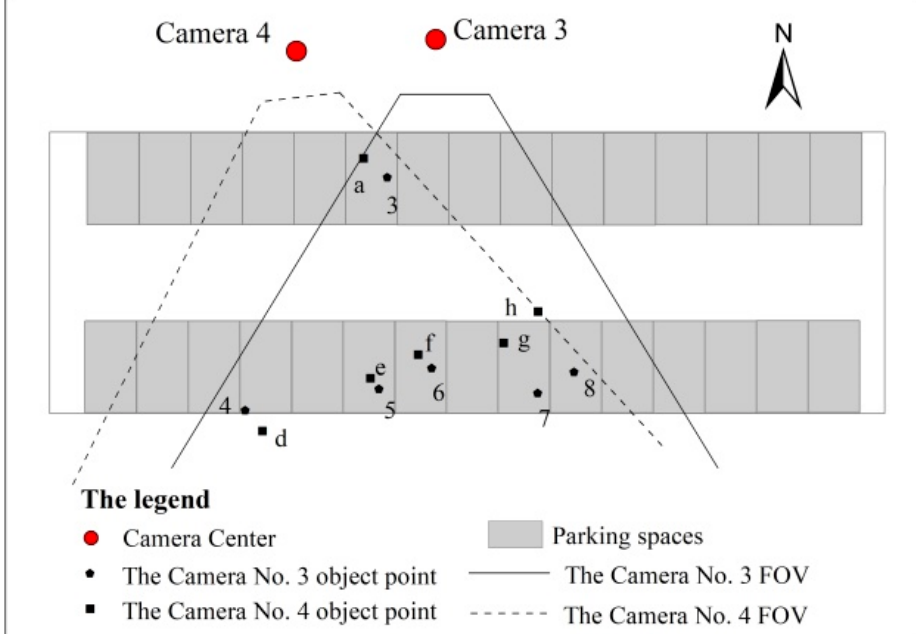
Figure 14. The objects’ distribution in the overlapping FOV of the parking lot.